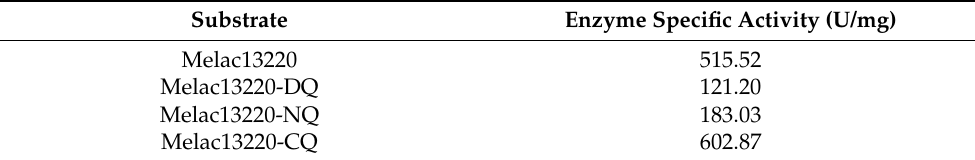
Table 1. The specific activity comparison of modified and original